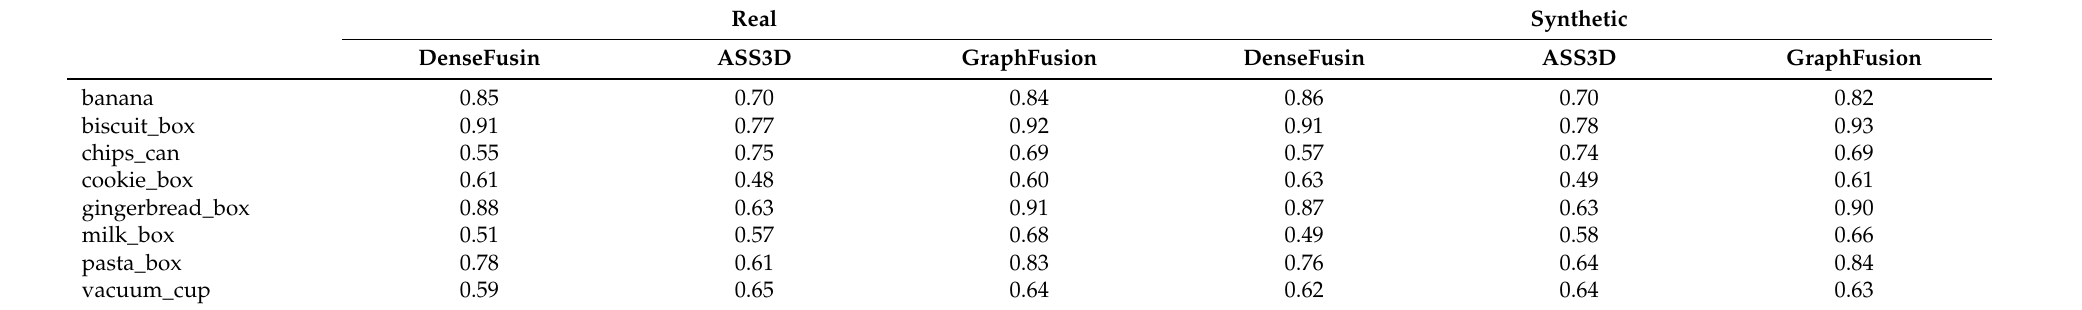
Table 7. The 6D pose estimation accuracy in terms of ADD using different input